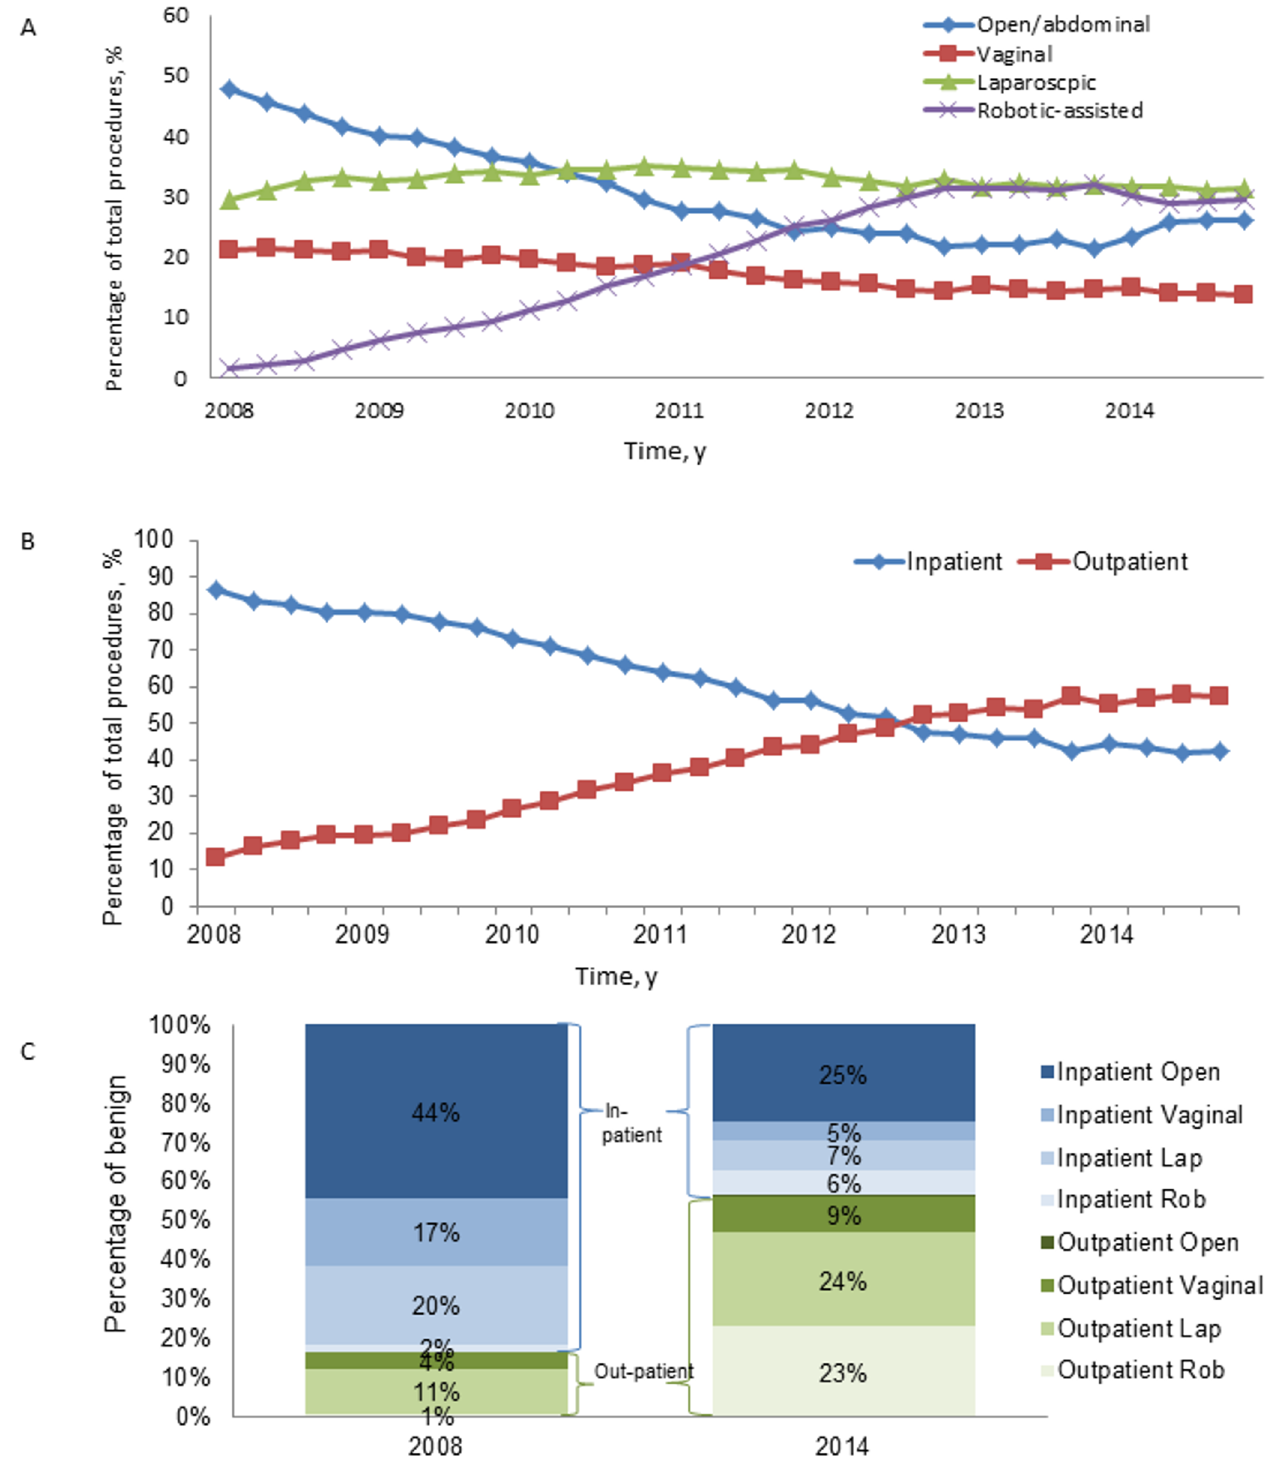
Fig 2. Trends for BH from Q1 2008 through Q4 2014. (A) All Visits by SurgicalApproach, (B) All Visits by Care Setting, and (C) All Visits by SurgicalApproachand Care Setting, 2008 and 2014 only. BH, benignhysterectomy; RH, robotic hysterectomy; y, year.